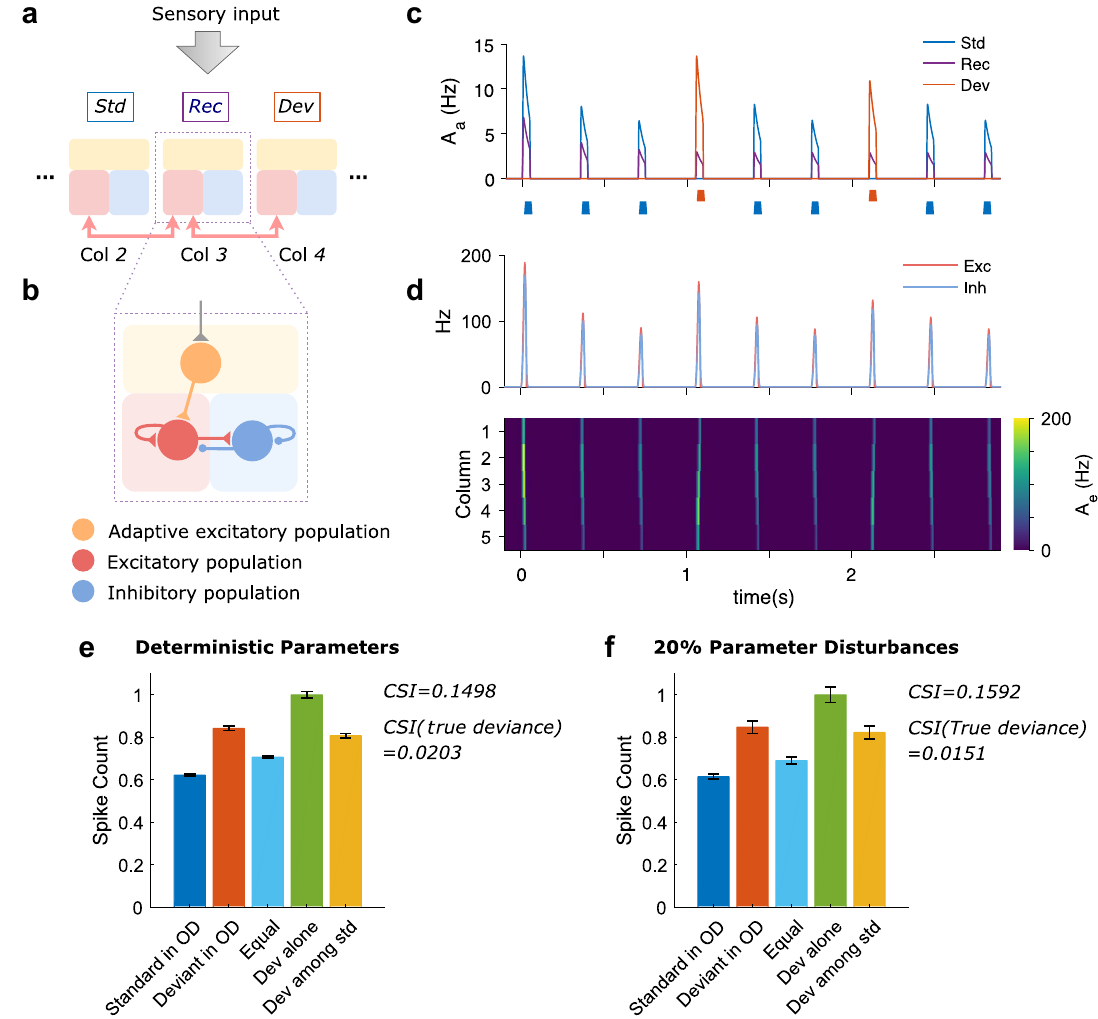
Figure 1. Oddball paradigms and SSA response of the network using a mean-field model. (a) The network model is composed of five cortical columns that are arranged along the frequency axis by their preferred frequencies (only the central three columns are shown here). Each column is constructed in three blocks: the adaptive layer (light yellow) receives thalamocortical sensory inputs and sends its feedforwards outputs to the excitatory (light red) population that is coupled with the inhibitory (light blue) population. The excitatory group is also connected to its nearest lateral excitatory counterparts, illustrated by arrows. During a “traditional” oddball paradigm, two different sensory stimuli are applied respectively to two symmetrical columns in our network: the standard (blue box) stimulates the left column at the probability of appearance of 0.75, while the deviant (red box) stimulates the right column with a probability of 0.25. The recording column in midway is the one from which the outgoing spikes are recorded (purple box). (b) To be detailed, within every column, the feedforward adaptive population excites a recurrent excitatory population that is regulated by another recurrent inhibitory population. The excitatory group is also activated by excitatory populations in its bilateral columns. A a in the standard column (blue) are often weaker than the deviant (red), yet either the (c) The adaptive population activities standard or deviant stimuli always trigger the same extent of activities in the recording column (purple) after the first several trials of stimulation. The stimuli sequence is shown under the plot. (d) Excitatory (pale red) and inhibitory (pale blue) populations in the recording column (column 3) often respond stronger to the deviant compared to the standard stimulation (top) because excitatory A e population activities in column 4 initiated by the deviant usually propagate more significantly into recording column midway than by the standard-triggered activities in column 2 (bottom). The time axis is vertically aligned for ( c , d ). (e) To investigate the deviant response characteristic, 5 control oddball (OD) protocols were used: “Standard in OD” in which a stimulus is presented to column 4 as a standard with a 75% probability of appearance (blue), “Deviant in OD” in which the same stimulus applied to column 4 was used as a deviant with a 25% probability of appearance (red), the “Equal” paradigm where two stimuli are presented 50% of the time each to column 2 and 4 respectively (cyan), “Dev alone” (green) where the stimulus is presented to column 4 alone as a deviant against silence and the “Dev among Std” (yellow) in which four different stimuli are presented 25% of the time each to column 1, 2, 4 and 5, respectively. The average responses in the recording column (spike count) to 5 different protocols are presented with the bar height representing the mean spike count with the standard error of the mean. The spike counts in each protocol are normalized to the Deviant alone condition. The data are averaged over responses of recording column to column 4 stimulation in each protocol consisting of 800 stimuli in total. In all simulation protocols, network parameters are chosen from Table 2, input amplitude A = 15 spikes/s, stimulus duration = 50 ms and inter-stimulus interval (ISI) = 300 ms (stimulus offset to onset). (f) The same setup was employed as (e) , except that 20% real-time parameter disturbances were introduced to parameters in Table 2, excluding the number of τ , τ e , τ i (cid:31) columns M , the width of tuning curve and the membrane time constants that were taken from the literature 15